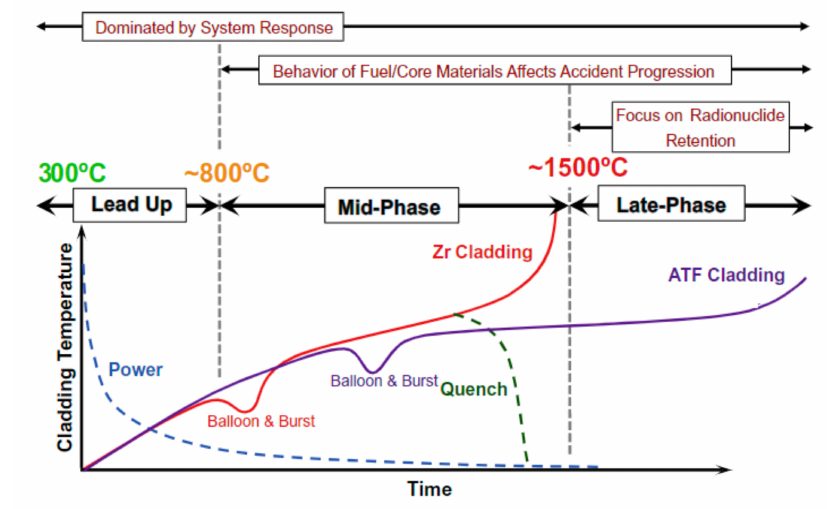
Figure 1. Pressurized water reactor accident progression scenario